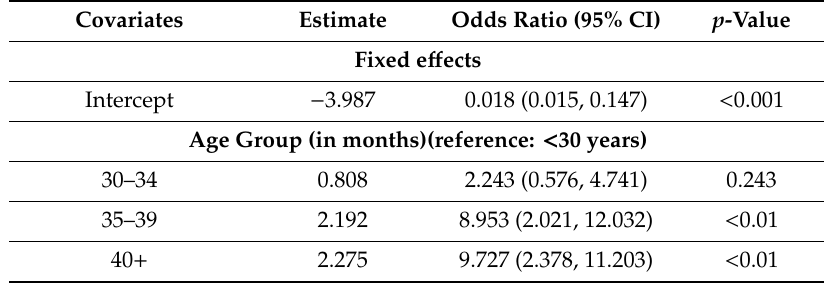
Table 2. Maximum likelihood estimates of multilevel random intercept logistic regression